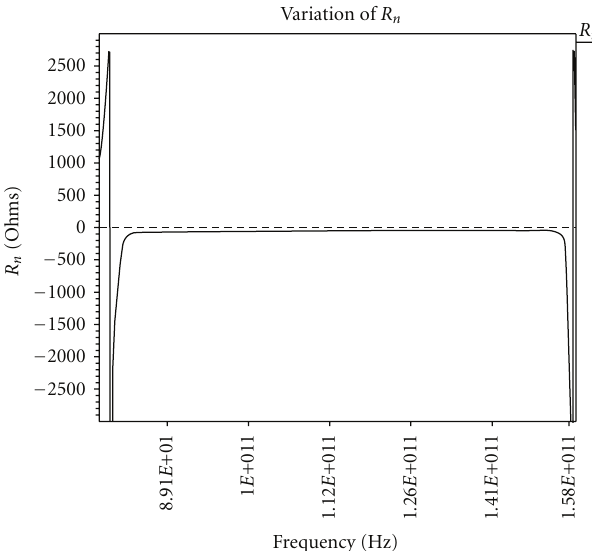
Figure 10: SPICE simulation of the negative resistance behavior of the bu ff er